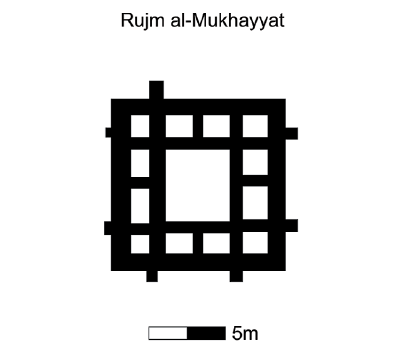
Figure 4: Schematic plan of Rujm al-Mukhayyat (after Benedettucci & Sabelli, 1998, p. 130, Figure